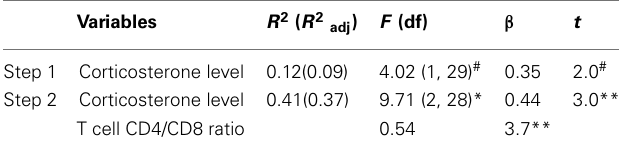
Table 3 | Regression analysis predicting depressive-like behavior